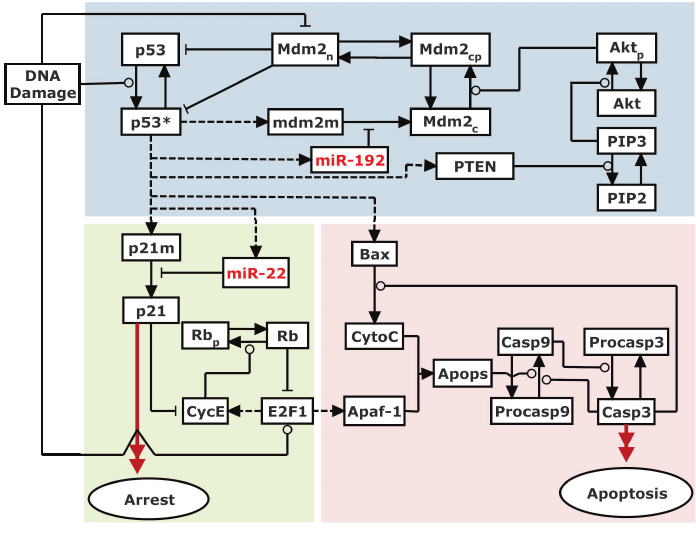
Figure 1. Schematic diagram of the integrated model. The model is mainly composed of three modules. The p53 regulation module considers three p53-centered feedback loops: one p53-Mdm2 negative feedback loop and two p53-PTEN-Akt-Mdm2 and p53-miR-192-Mdm2 positive feedback loops. Cell cycle arrest is induced through p21-dependent inhibition of E2F1, while apoptosis is triggered via the caspase cascade activated by Bax and Apaf-1. Notably, miR-22-dependent p21 repression facilitates E2F1 activation. Dashed lines denote gene transcription induced by p53 and E2F1. Solid arrowed lines represent transitions between different forms. Promotion and inhibition of the components are denoted by circle-headed and bar-headed lines,